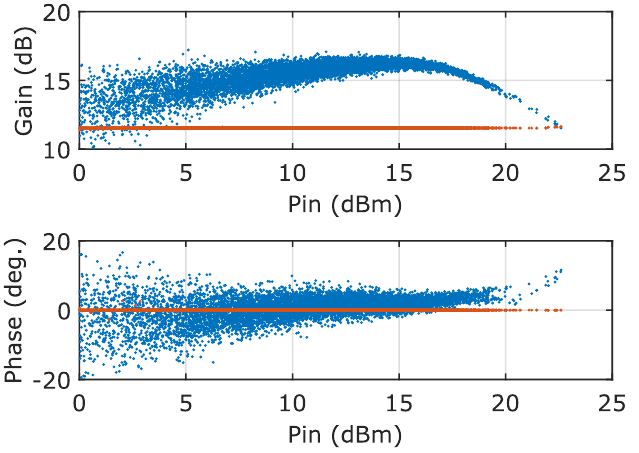
Figure 13. PA gain and AM/PM characteristics before (blue lines) and after linearization (red lines) at optimal point